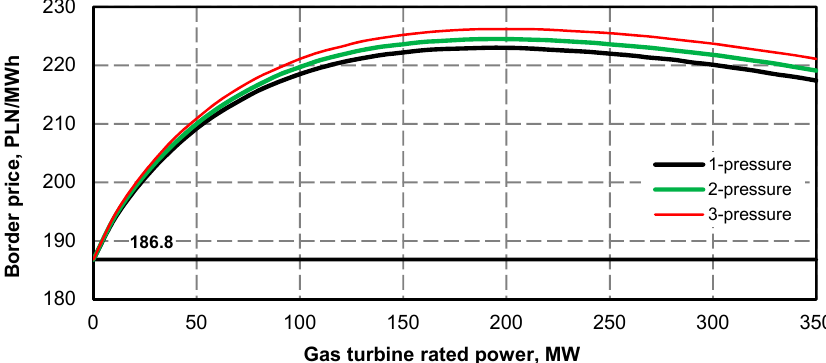
Figure 44. Unit generation cost for electric power as a function of gas turbine rated power for various structures of recovery boiler after increasing 10 times the emission rates for CO 2 , CO, SO 2 , NO x and dust ( e c = 10.0 PLN / GJ, e g = 27.7 PLN / MWh, (k el ) ex = 186.8 PLN /